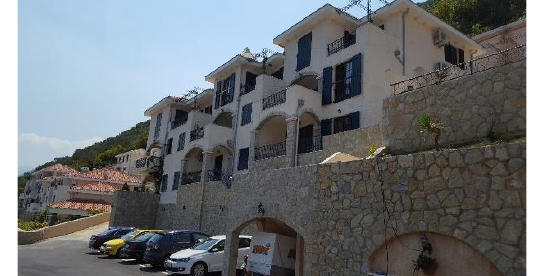
Figure 9. Excessive height of the new building and the retaining walls (Source: Kosara